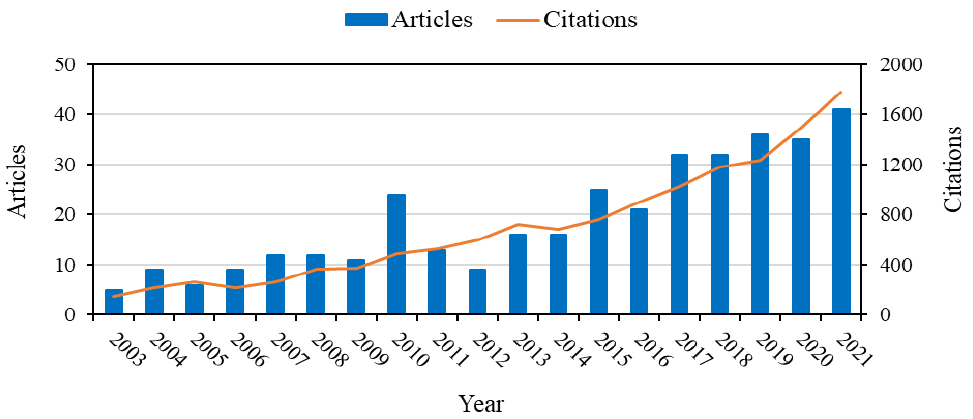
Figure 1. Number of articles in the last years addressing the evaluation of polymers used to produce formulations devices for oral cavity application and the citations associated with these publications. The literature search was based on Web of Science, with the keywords “Polymers + oral